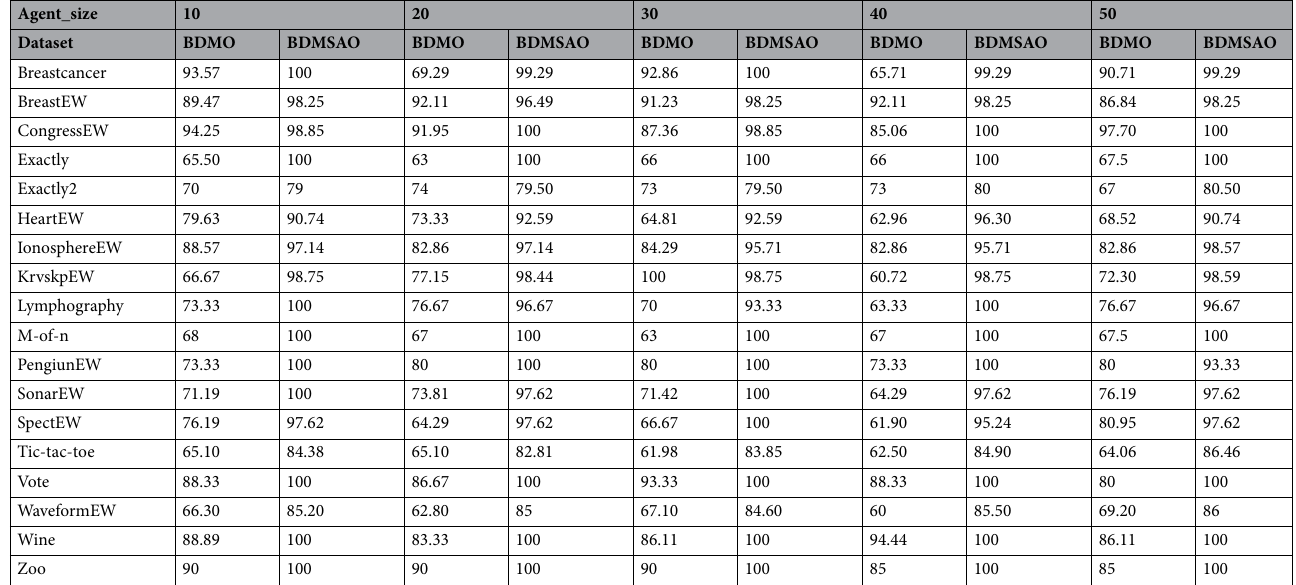
Table 3. The classification accuracy of BDMO and BDMSAO on different population sizes.